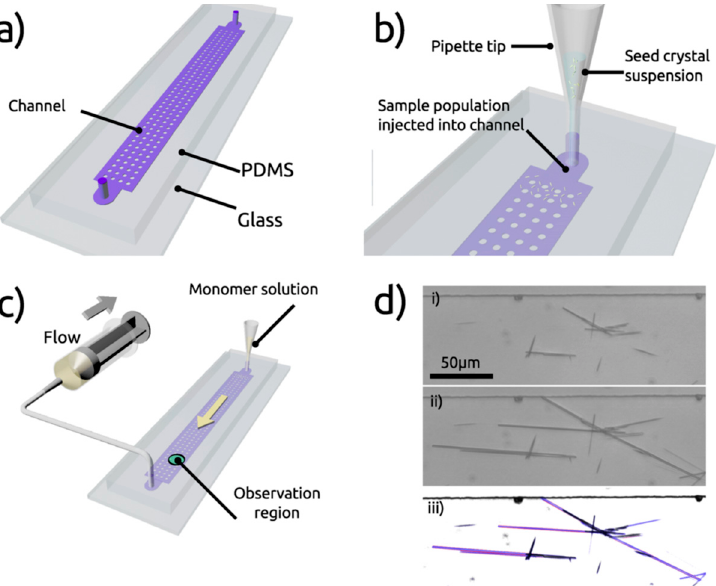
Figure 3. Microfluidics platform for the control of peptide self-assembly. ( a ) presentation of the microre-actor (multiple inlets and central chamber), ( b ) injection of seed crystals, ( c ) injection of a saturated solution of FF, ( d ) images via optical microscopy. With permission from Reference [32].